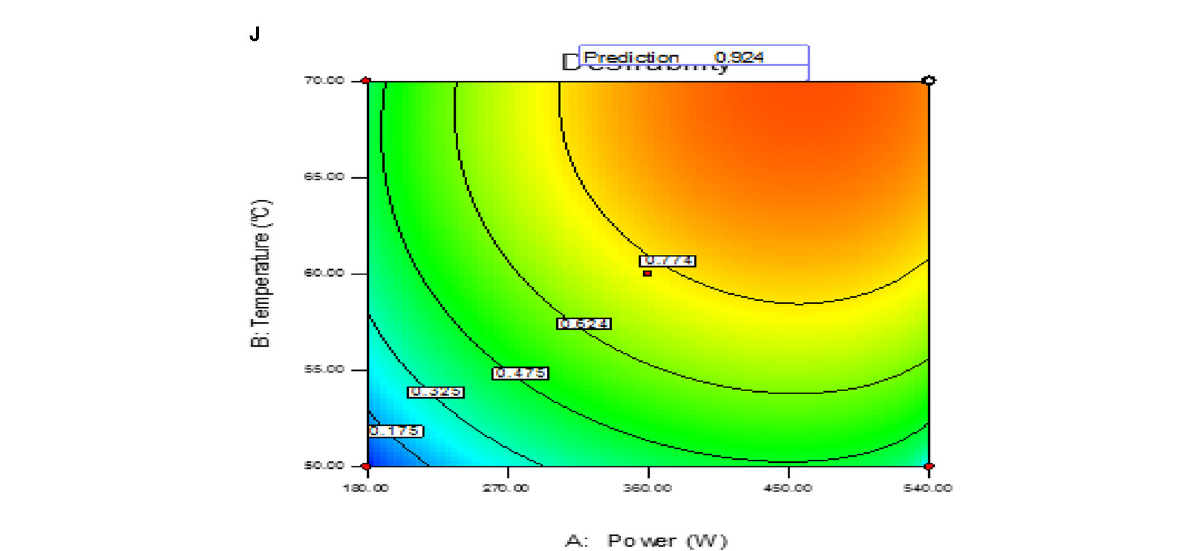
FIGURE1 (A) Experimental apparatus (Microwave assisted fluidized bed drying system) (I) schematic diagram (II) in a working condition. (B) Response surface plots showing combined effect of microwave power, temperature and inlet air velocity) on ascorbic acid content. (C) Response surface plots showing combined effect of microwave power, temperature and inlet air velocity) on total phenolic content. (D) Response surface plots showing combined effect of microwave power, temperature and inlet air velocity) on total flavonoid content. (E) Response surface plots showing combined effect of microwave power, temperature and inlet air velocity) on DPPH radical scavenging activity. (F) Response surface plots showing combined effect of microwave power, temperature and inlet air velocity) on total chlorophyll content. (G) Response surface plots showing combined effect of microwave power, temperature and inlet air velocity) on carotene content. (H) Response surface plots showing combined effect of microwave power, temperature and inlet air velocity) tannin content. (I) Response surface plots showing combined effect